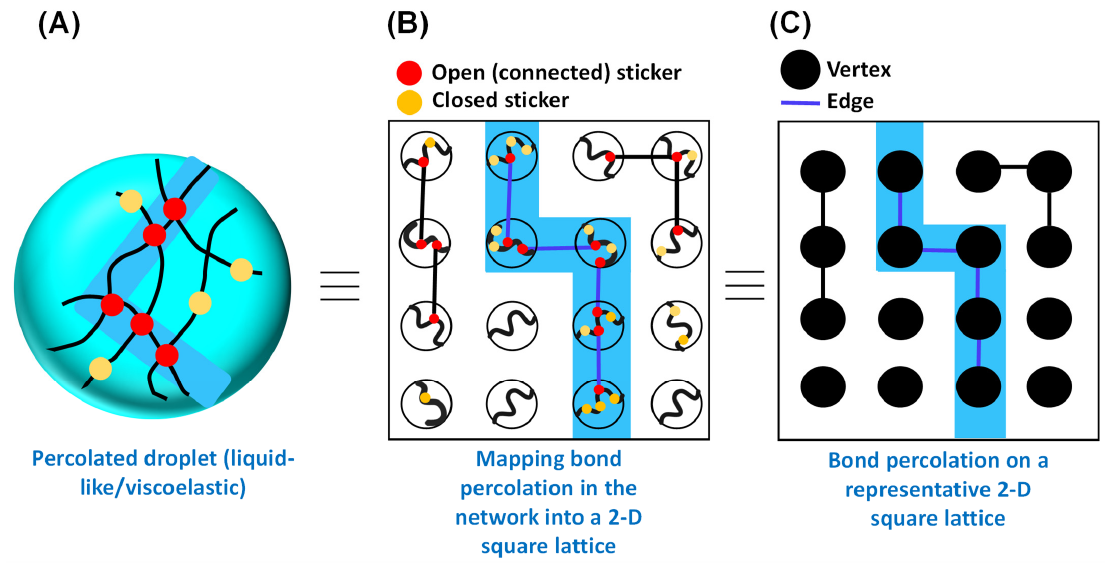
Figure 2. Mapping the bond percolation of a representative 2-D square lattice onto the physical crosslinks in the percolated network within the phase separating biomacromolecules. ( A ) Schematic representation of physical crosslinking formed by sticker–sticker interactions within the percolated droplet. Polymer chains are shown in black. Red circles define the open (connected) stickers, and yellow circles define the closed stickers. The percolating cluster (open path) is shown by the light blue shade. ( B ) Conceptualization of bond percolation in the context of percolated droplet. ( C ) Bond percolation on a representative 2-D square lattice, as proposed by Broadbent and Hammersley in the context of an arbitrary linear graph with vertices and edges. The color code remains the same as ( A